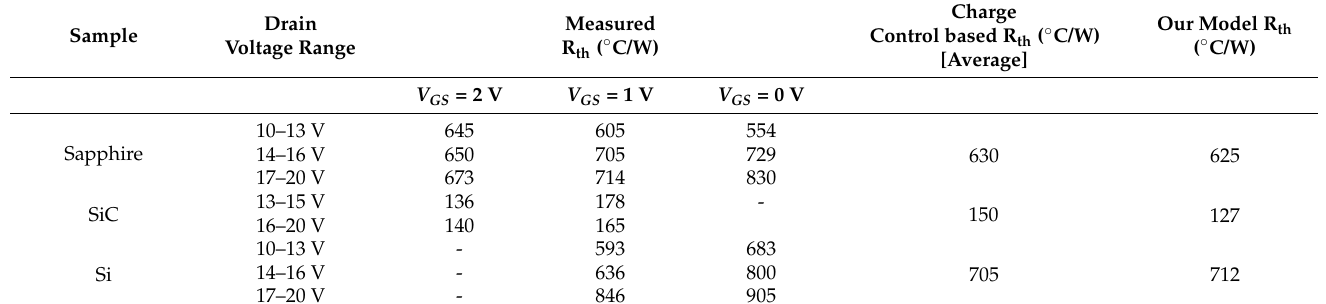
Table 4. Comparison of thermal resistance in the DC measurement method, the charge control model, and our proposed model.